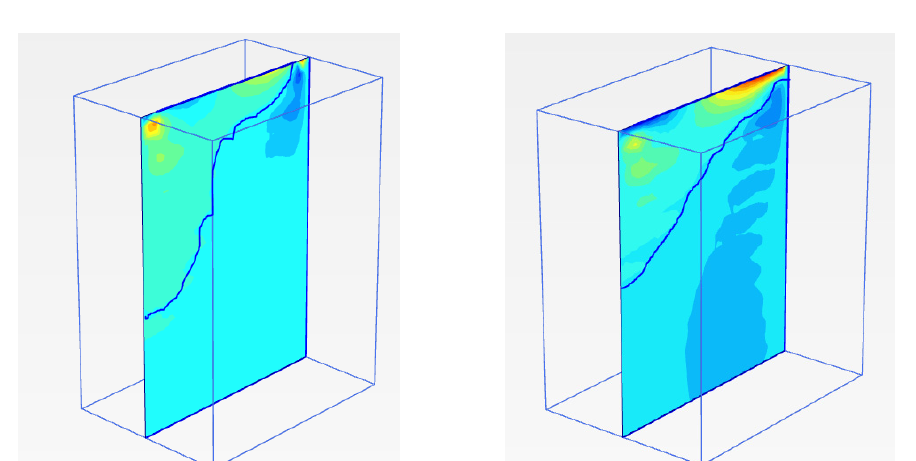
Figure 11. ( a ) Major strains observed by digital image correlation analysis in Plaxis 3D at the sliding surface in the sand only; ( b ) Major strains observed by digital image correlation analysis in Plaxis 3D at the sliding surface of tire shred-sand mixture.